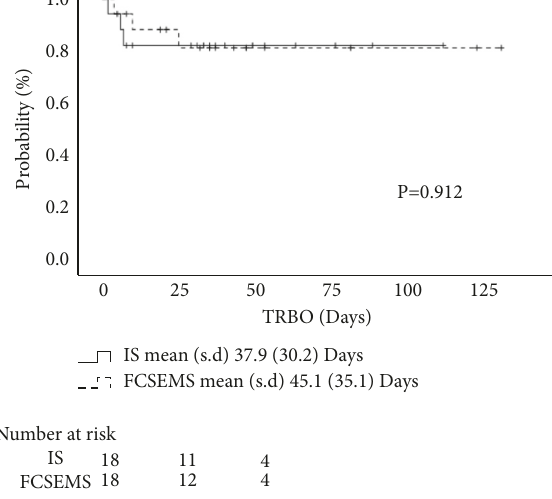
Figure 3: Time to RBO for each stent after propensity score matching. The mean (SD) time to RBO was 37.9 (30.2) days in the IS group and 45.1 (35.1) days in the FCSEMS group, with no significant difference ( P � 0 . 912, log-rank test). RBO, recurrent biliary obstruction; IS, inside stent; FCSEMS, fully covered self- expandable metallic